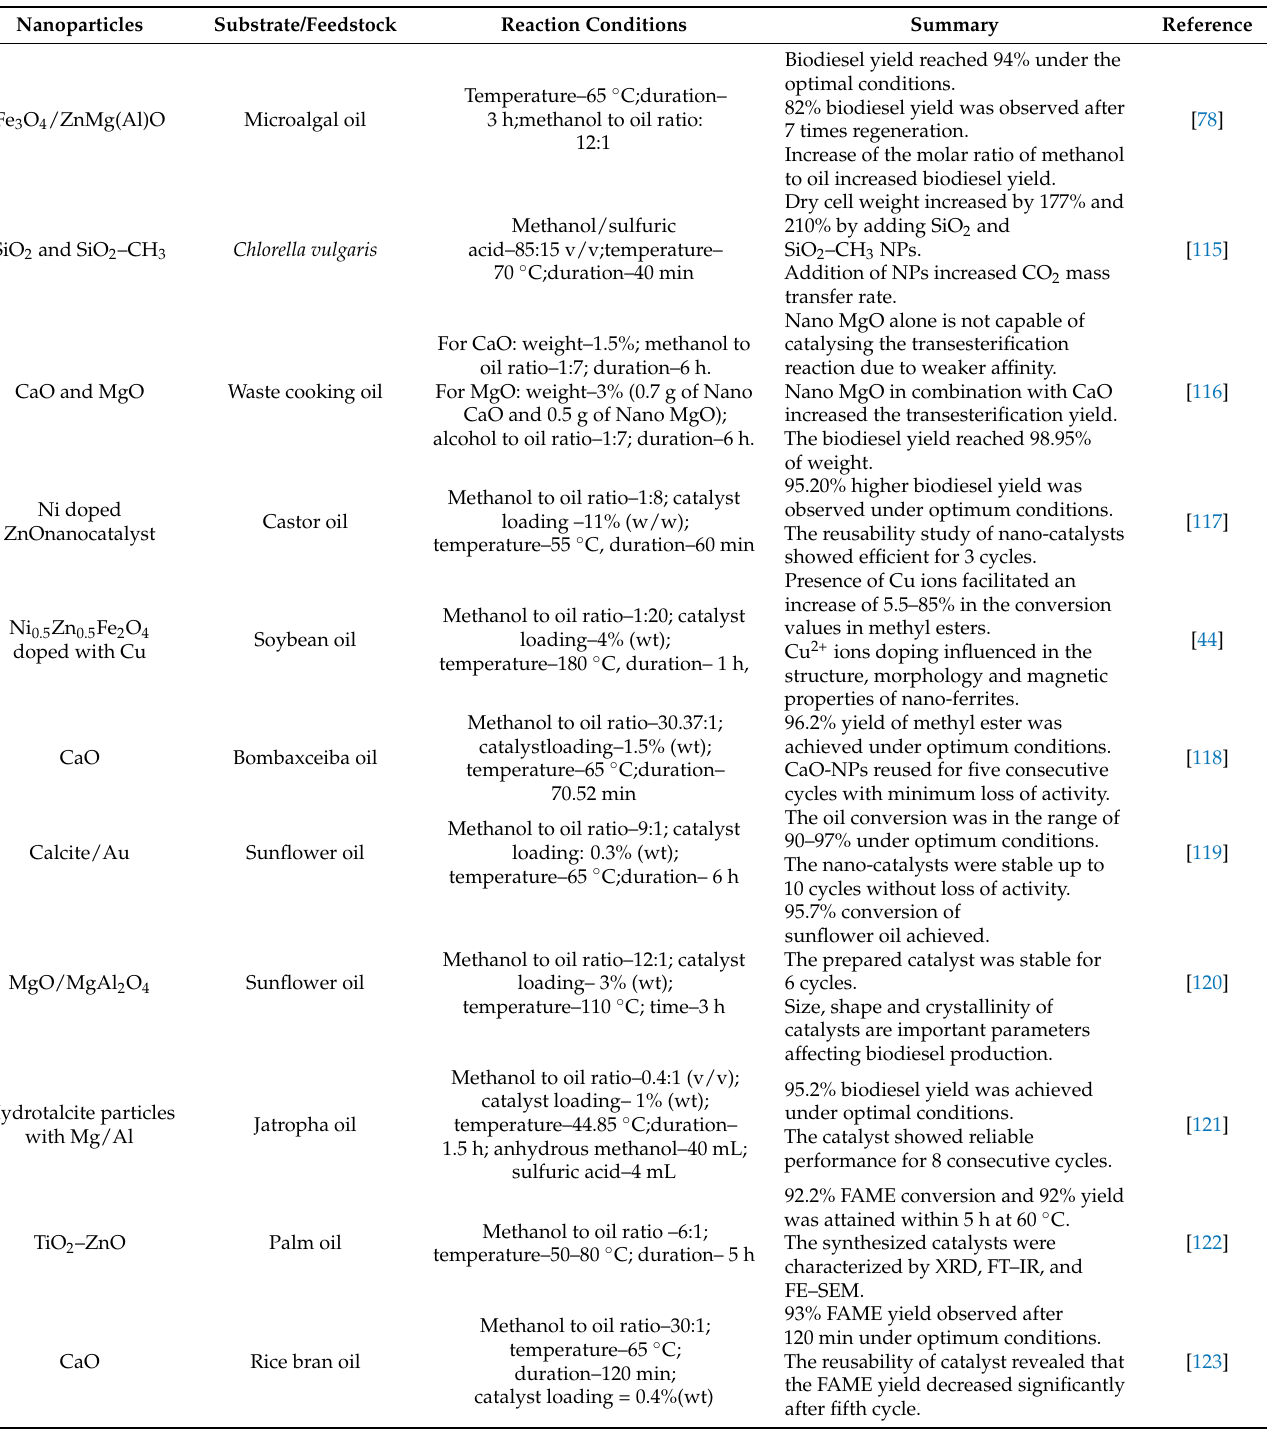
Table 4. Summary of application of nanoparticles in biodiesel production